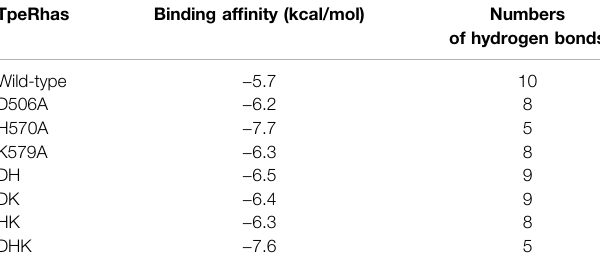
TABLE 3 | Parameters affecting the docking of mutants and icariin complexes.